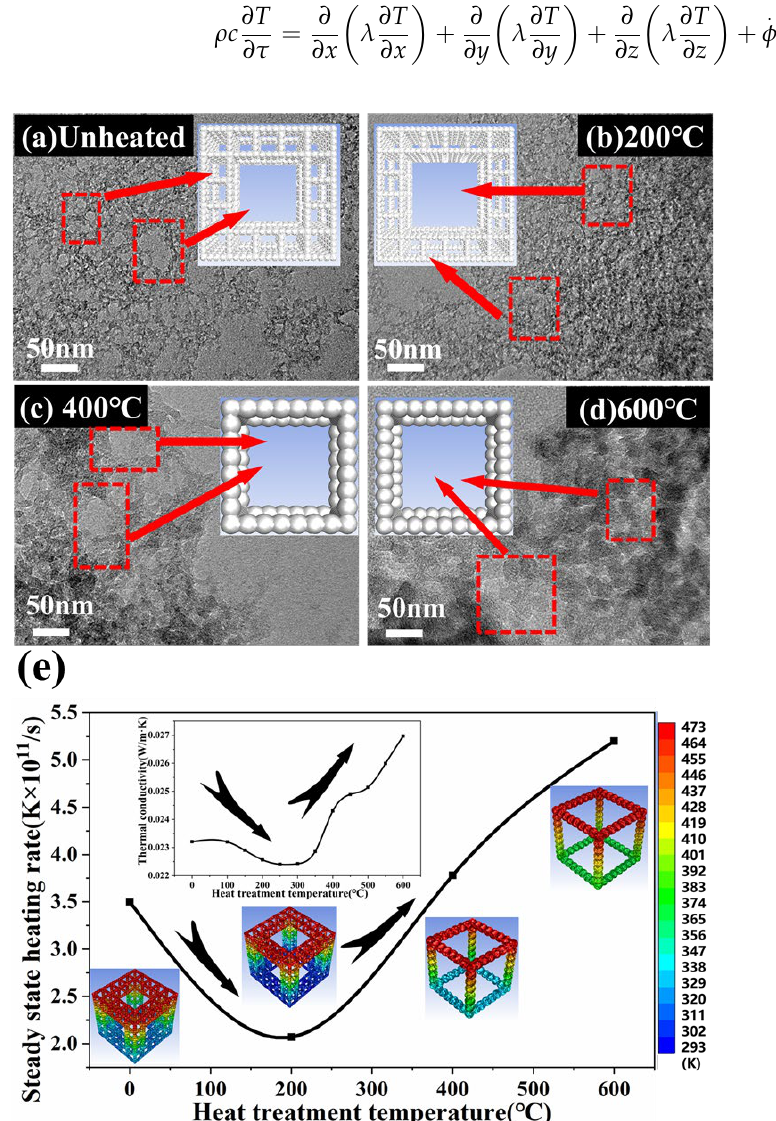
Figure 8. TEM images and corresponding structural models of the silica aerogel samples treated at different temperatures. ( a ) Unheated, ( b ) 200 °C, ( c ) 400 °C, ( d ) 600 °C. ( e ) Comparison of steady state heating rate and thermal conductivity trend of silica aerogel samples treated at different temperatures.